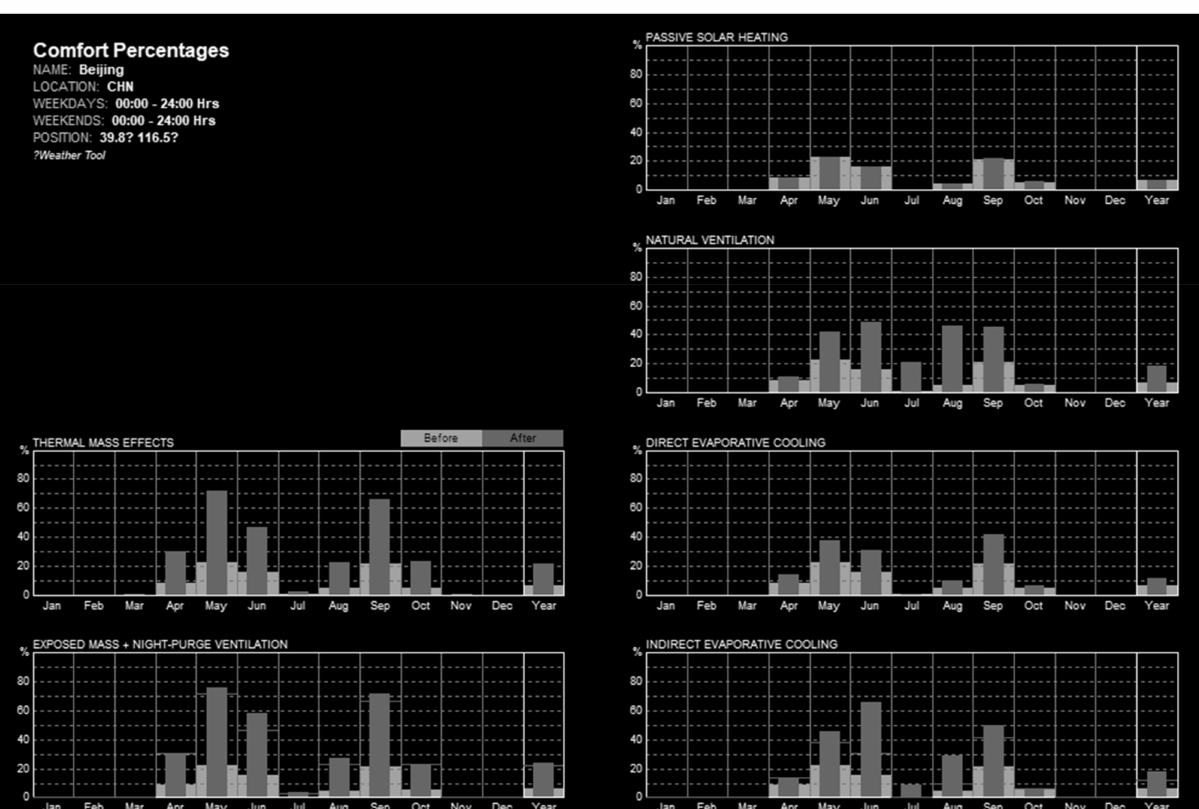
Figure 20. Thermal comfort